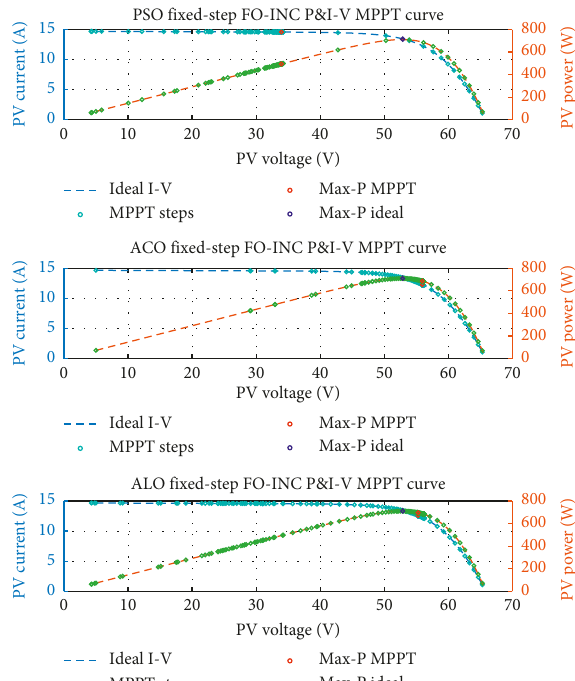
Figure 11: Optimization of fixed-step FO-INC I-V and P-V curves.